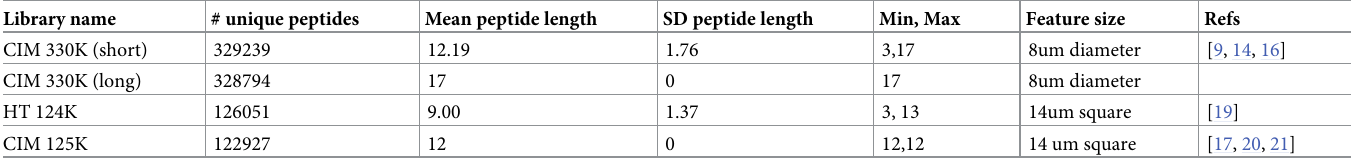
Table 1. Description of peptide libraries used in this project. Four libraries were constructed using mask-based lithography synthesis. Each library is synthesized on sili- con wafers coated with silicon oxide. Every library is made in a 0.49cm2 area, 24 separate assays are arrays on a standard 25mm x 75mm slide in an 8x3 design. Every array was assayed under the same